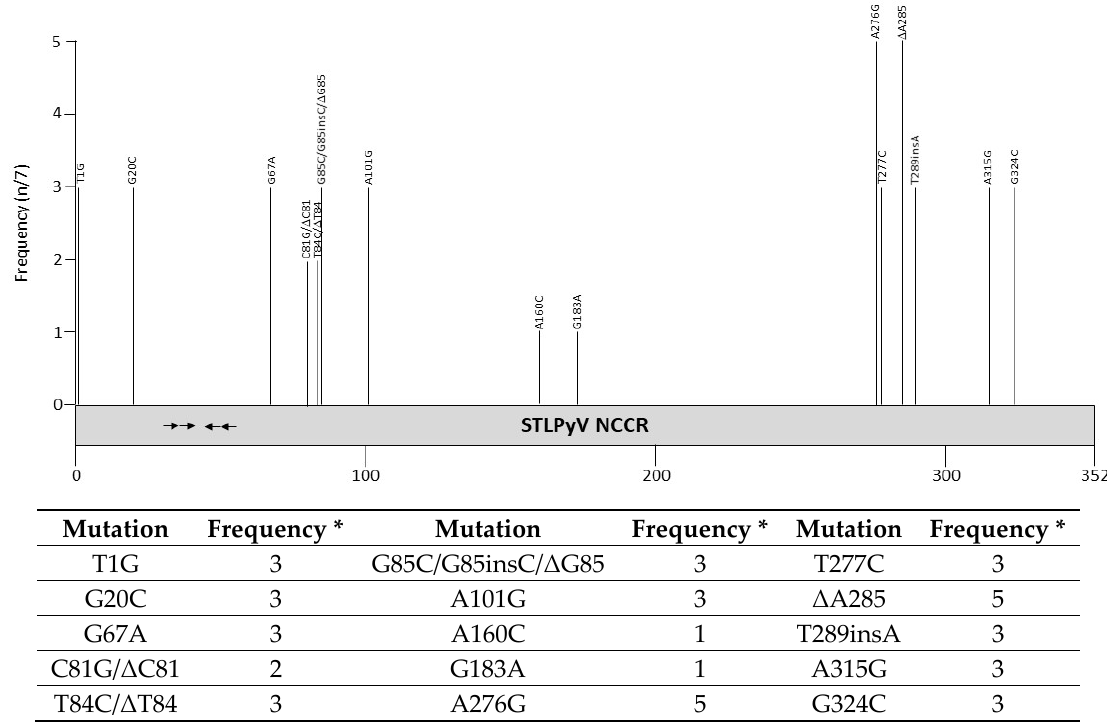
Figure 9. Mutations and their prevalence in variants of Saint Louis polyomavirus (STLPyV) noncoding control region (NCCR). The numbering of the NCCR is from early to late with nucleotide 1 being the most proximal to the ATG start codon of the early genes and the most distal nucleotide, just upstream of the start codon of the VP2 gene. The number of times a peculiar mutation is found in the different variants is given as frequency (with n the number of times the mutation was described/total NCCR variant sequences available). Putative Large T antigen (LT) binding motifs 5 ′ -GRGGC-3 ′ ( → ) or 5 ′ -GCCYC-3 ′ ( ← ) are shown. The table summarizes the mutations, their location in the NCCR, and their frequency. For details see Table S1. Putative transcription factor binding sites are shown in Supplementary Table S2.